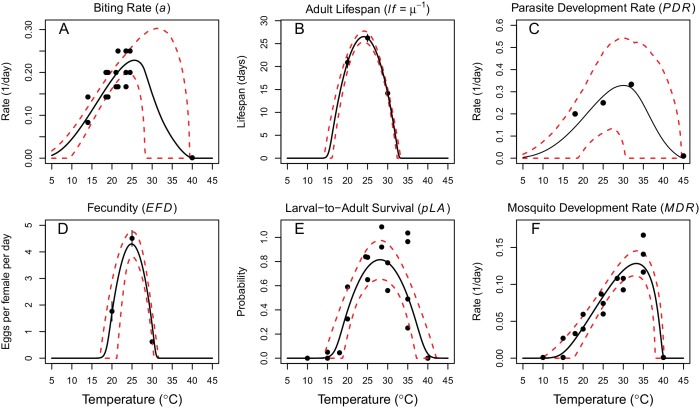
Thermal responses of Cx. annulirostris fit with uniform priors.